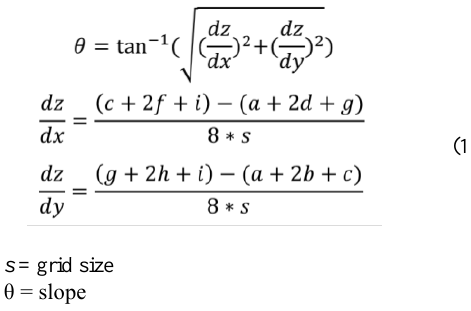
Figure 1. The example to explain the slope